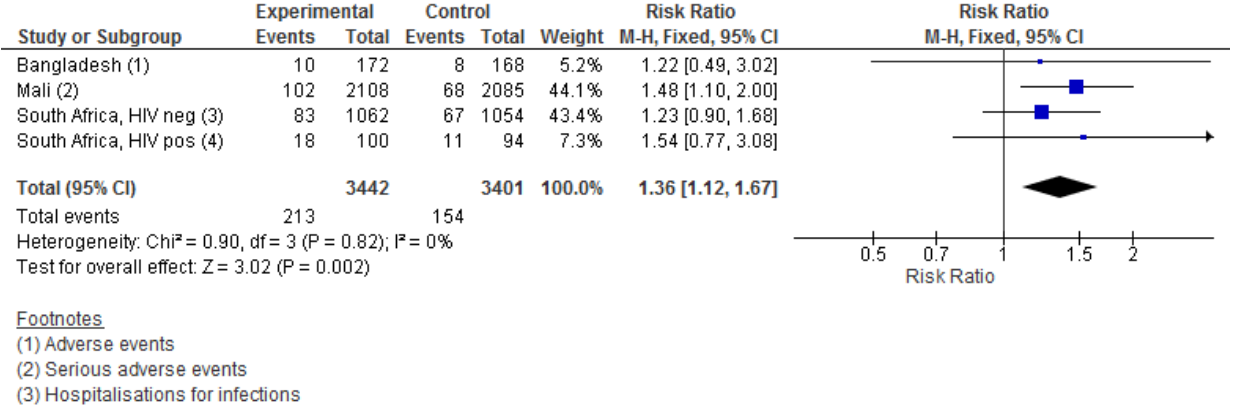
of sepsis <3 days in each group was assumed to be included in the cases of sepsis <28 days and therefore not counted